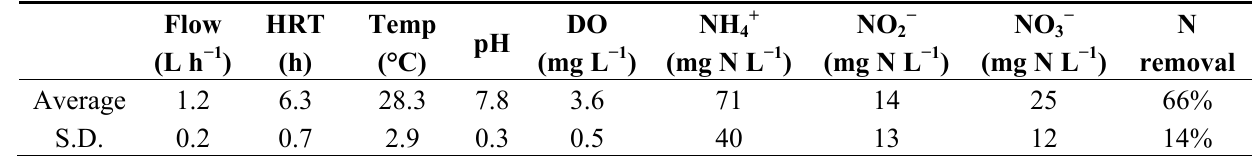
Table 1. Reactor conditions and effluent concentrations during the experimental period. Average values and standard deviation (SD). The influent (synthetic wastewater)